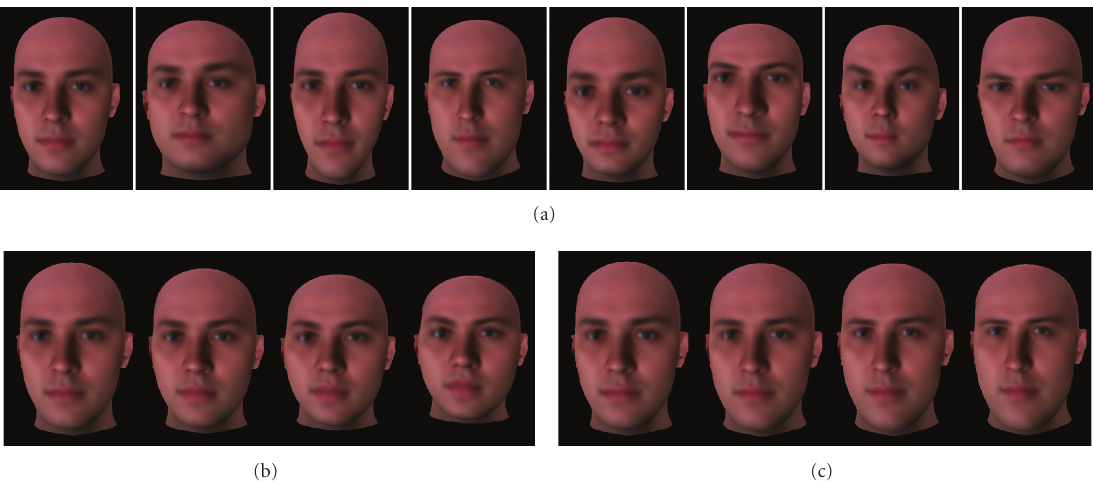
Figure 10: (a) New faces synthesized from the average model (leftmost) with global and local shape variations. (b) and (c) Face shape morphing (left to right in each example).